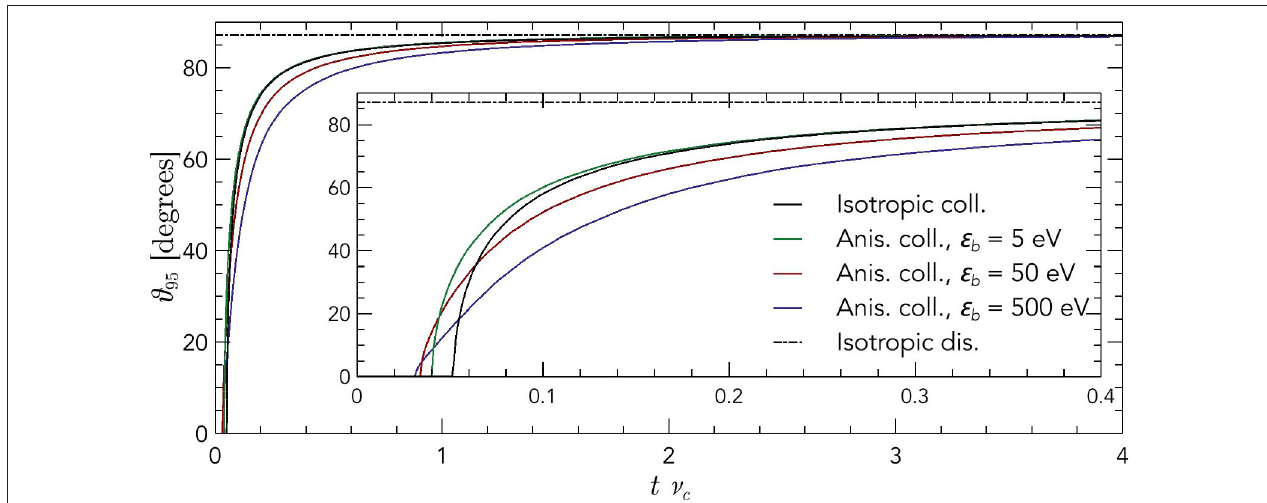
FIGURE 1 | Time evolution of the divergence of an initially directed electron packet propagating in a background gas for different beam energies ǫ b and elastic collision models. ϑ 95 is defined in Equation (4). Both isotropic and anisotropic models converge toward an isotropic distribution after a few collisions. However, for t ν c ≤ 0.2, with ν c the momentum-transfer collision frequency, the isotropic model is observed to over-predict electron deflection in the high energy